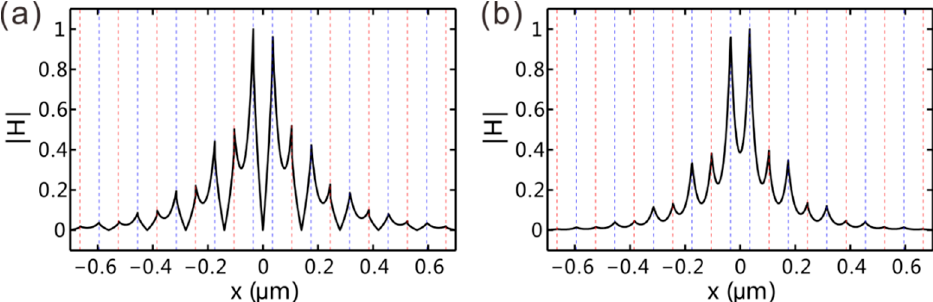
Figure 3. The field distributions for (a) topological bound mode and (b) trivial defect mode.